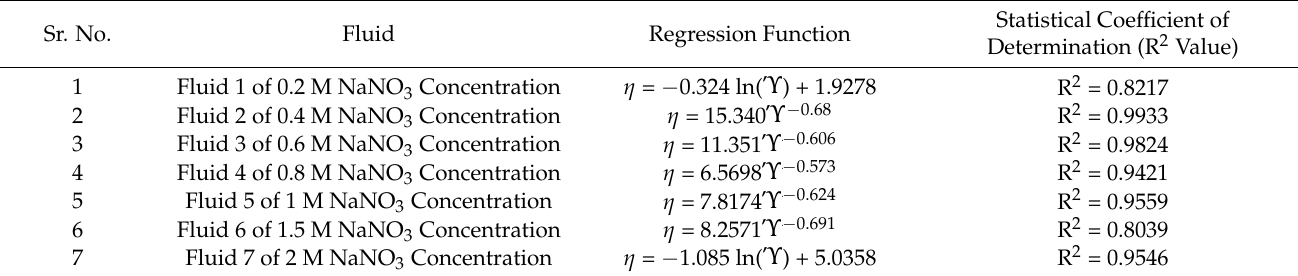
Figure 8. Comparison of viscosity plot of type2 viscoelastic fluids containing 0.6 M and 0.8 M NaNO 3 concentration at different temperatures. Table 2. Regression functions for viscosity change with a varying shear rate of different viscoelastic type2 fluids at a temperature of 25 ◦ C.